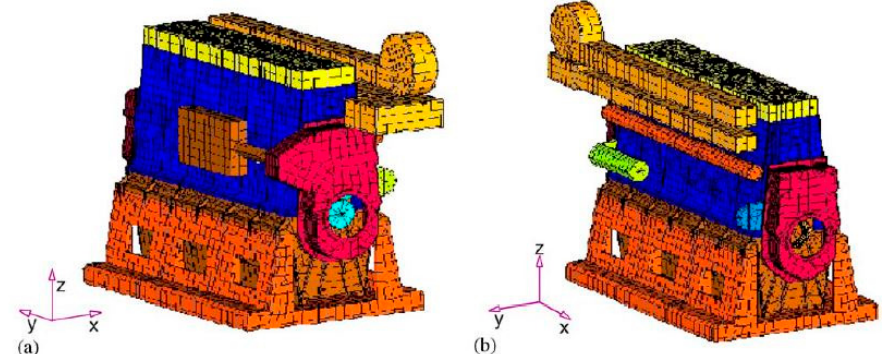
Figure 12. Multi-body analysis (MBA) model of a 6160 diesel engine. ( a ) Left and ( b ) right part of the